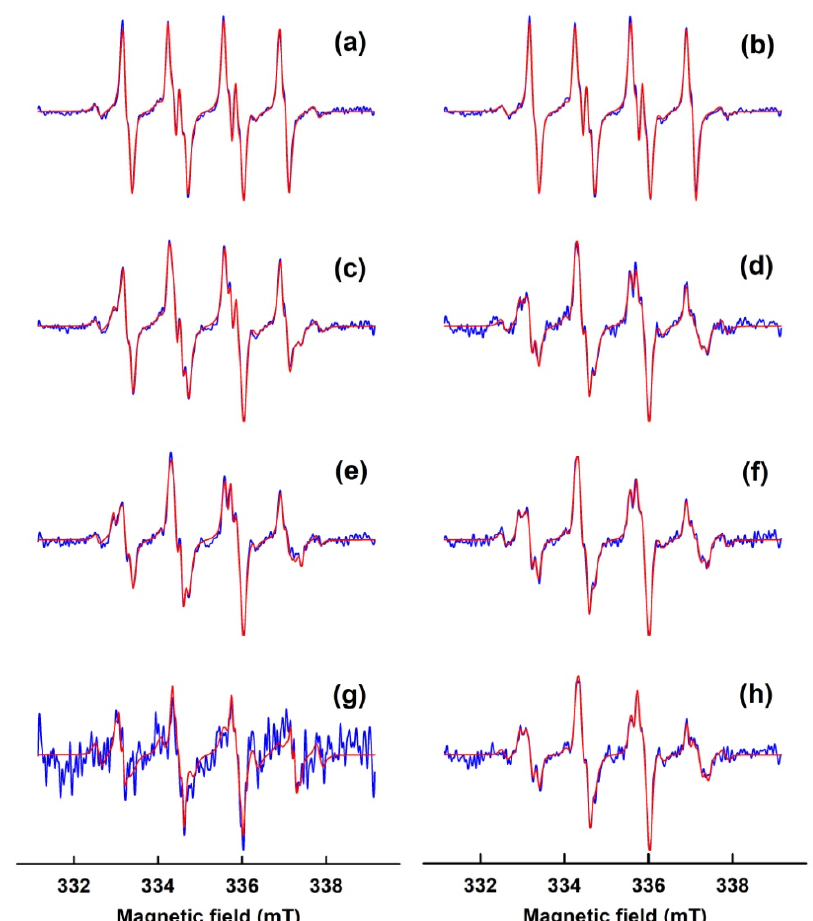
Figure 3. Representative normalized experimental EPR spectra of the BMPO-adducts along with their simulation using the hyperfine coupling constants summarized in Table 1. Experimental spectra of the sixth to tenth accumulated spectra are shown only (blue); simulated spectra are red. ( a ) Control 30 mmol L − 1 BMPO + KO 2 and after addition of ( b ) 25 µ mol L − 1 SeO 32 − , ( c ) 25 µ mol L − 1 H 2 S, ( d ) 25 / 25 (in µ mol L − 1 ) H 2 S / SeO 32 − , ( e ) 25 µ mol L − 1 Na 2 S 2 , ( f ) 25 / 25 (in µ mol L − 1 ) Na 2 S 2 / SeO 32 − , ( g ) 25 µ mol L − 1 Na 2 S 4 and ( h ) 25 / 25 (in µ mol L − 1 ) Na 2 S 4 / SeO 32 −